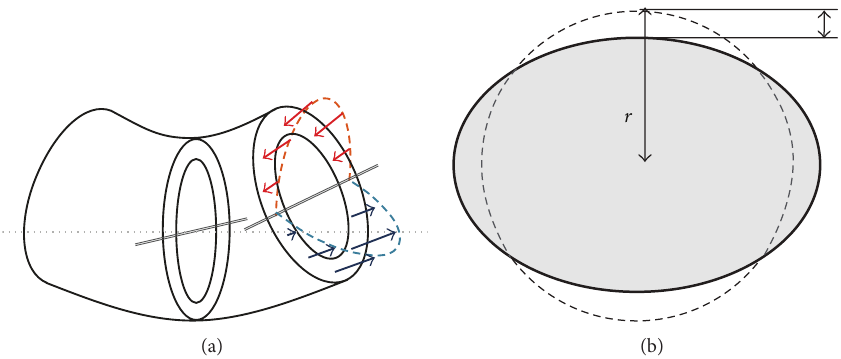
Figure 1: (a) Schematic of the Brazier effect. Bending application to a hollow cylinder of circular section gives rise to the stresses indicated by arrows colored in red and blue. The compressive (red arrow) and tensile (blue) stresses act at a certain angle to the unrotated section, as a result of which the original circular shape deforms into an oval or flattened shape. (b) Definition of the oblateness parameter 𝜁